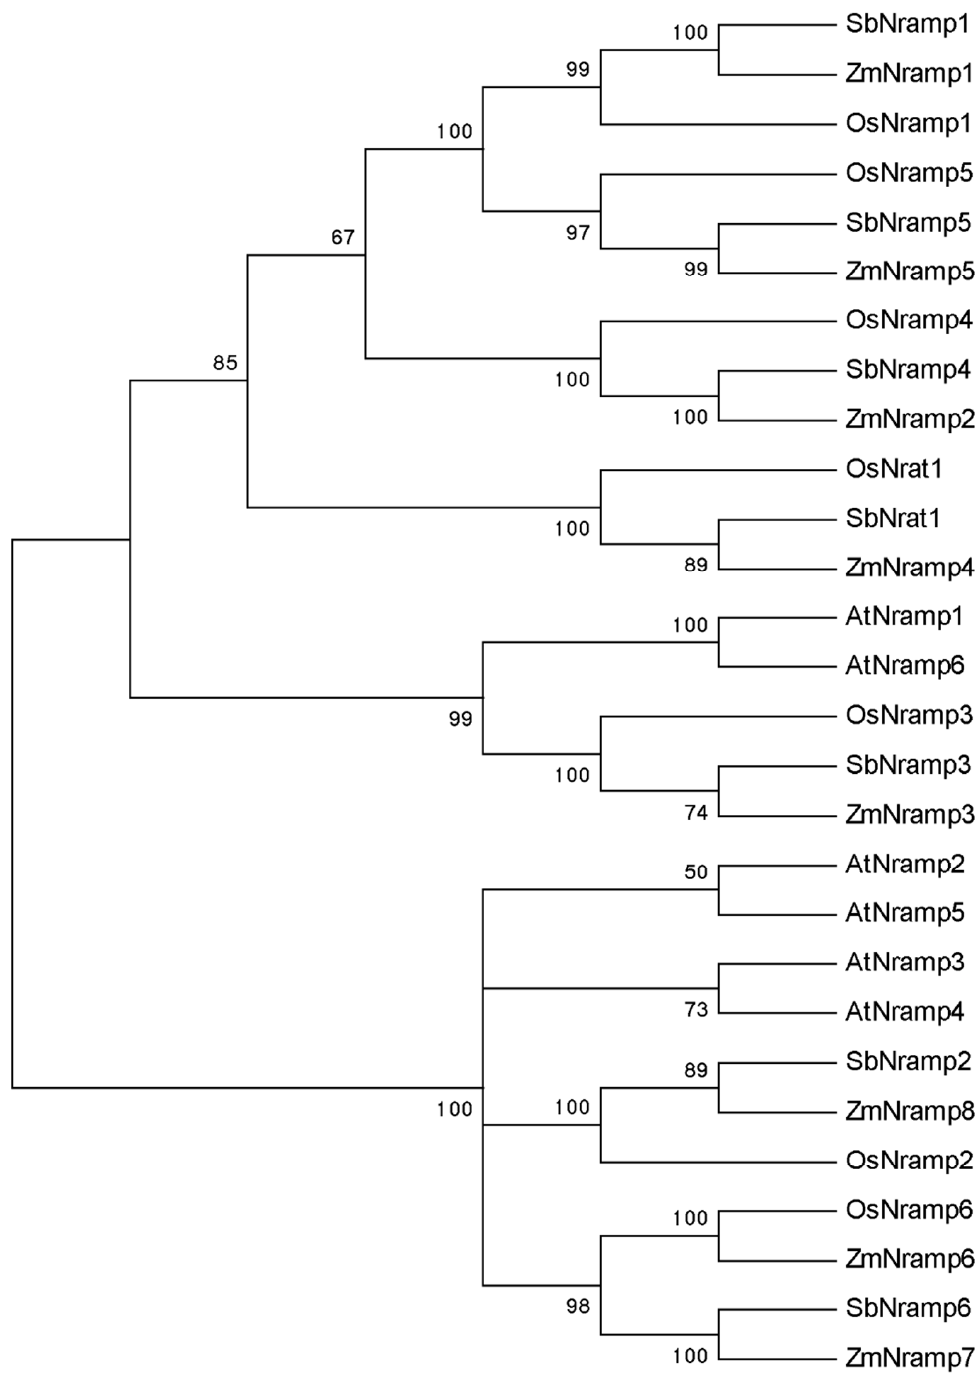
Figure 1. Phylogenic tree of ZmNRAMP4 with NRAMPs from Arabidopsis , rice, sorghum, and maize. The information of accession number and species for NRAMPs is as follows, including AtNRAMP1 to AtNRAMP6 (AT1G80830, AT1G47240, AT2G23150, AT5G67330, AT4G18790, AT1G15960), OsNRAMP1 to OsNRAMP6 (Os07g15460, Os03g11010, Os06g46310, Os07g15370, Os12g39180, Os01g0503400), OsNrat1 (Os02g0131800), SbNRAMP1 to SbNRAMP6 (XP_002459640, XP_002465667, XP_002438846, XP_021317241, XP_002461772, XP_002464246), SbNrat1 (XP_002451480), ZmNRAMP1 to ZmNRAMP8 (Zm00001d005479, Zm00001d007397, Zm00001d014391, Zm00001d015133, Zm00001d019327, Zm00001d030846, Zm00001d033367,